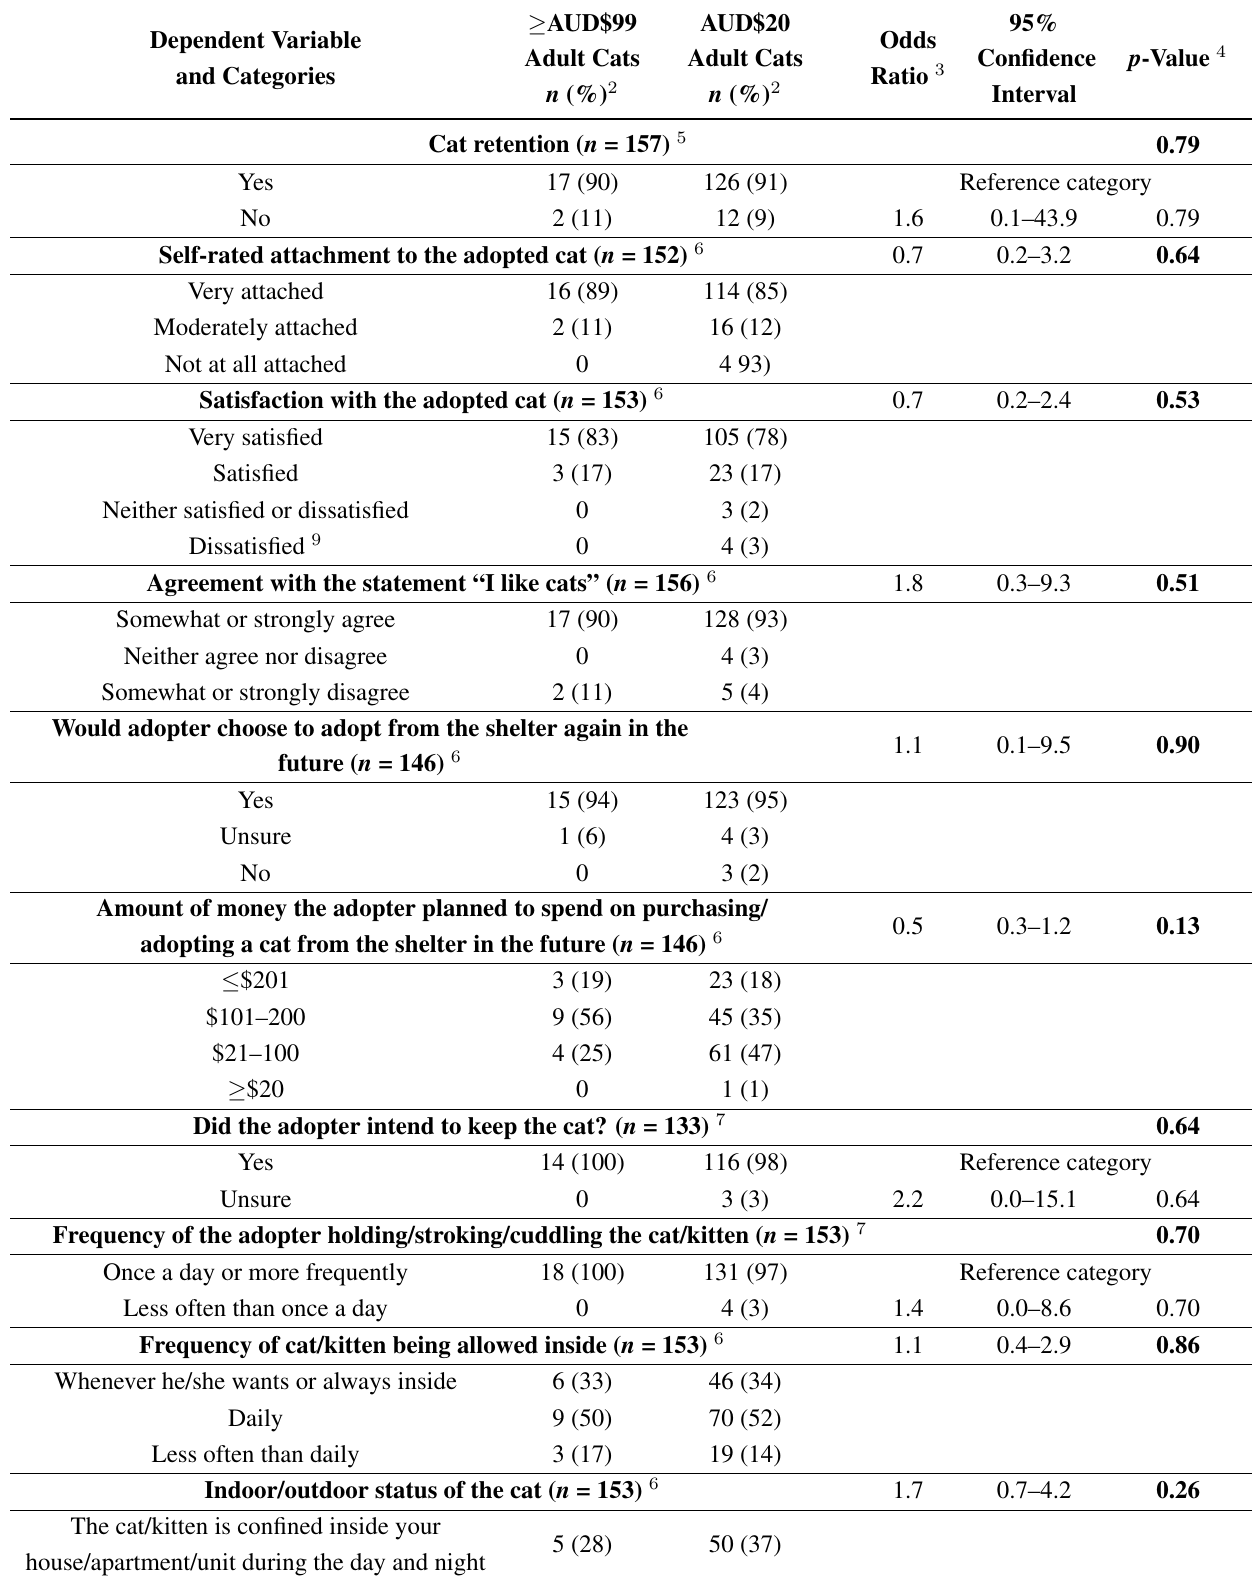
Table S5. Distributions of adoption outcomes by cat adoption price for 152 adult cats adopted from an animal shelter in Australia in 2013 for variables with overall p -values ≥ 0.05 on univariable analyses comparing distributions between adoption price